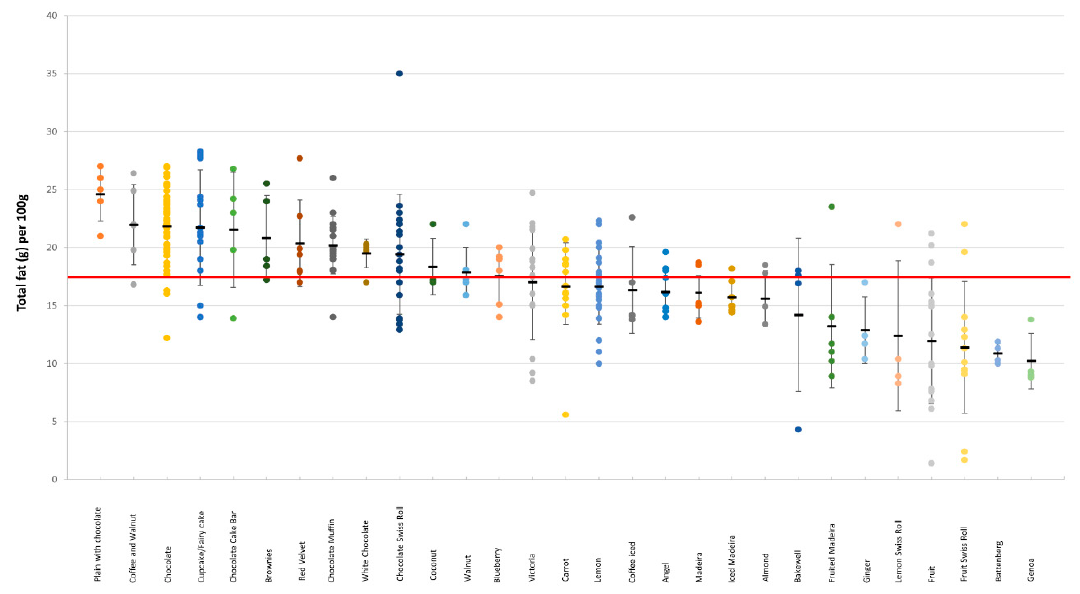
Figure 2. Total fat content (g/100 g) in different categories of cakes. The red line denotes the high criteria for total fat.